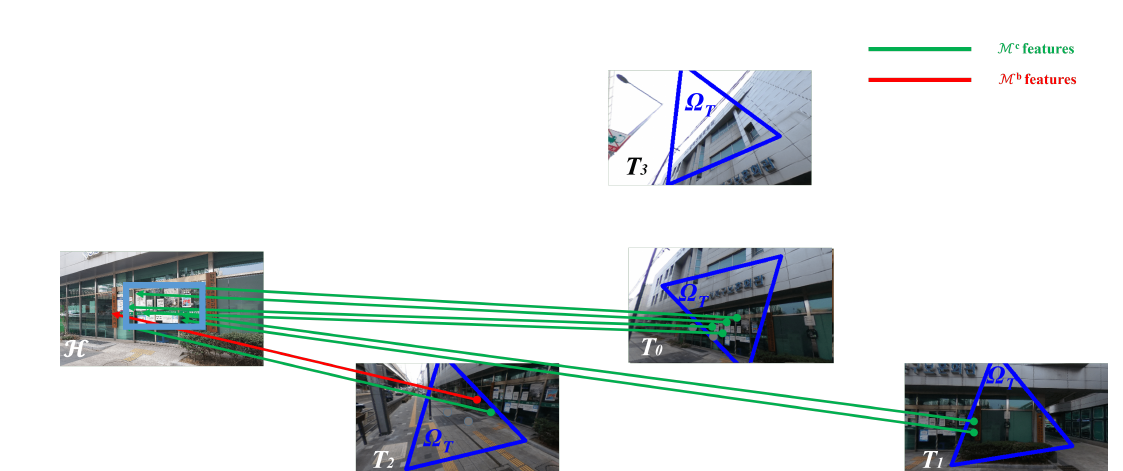
Figure 6. ROI tangent image (ROI-TI) selection. We use the central accumulated matched features (central AMF) M c to pick the ROI-TI. The central AMF has the corresponding features located inside the high angular resolution planar image (HPI) H central region (i.e., the light blue rectangle box). For example, the (TI) T 2 has two features in total, but one is located outside the light blue rectangle. Thus, T 2 only has one central AMF in total. Meanwhile, T 0 has four central AMF in total: the highest among the others. We then select T 0 as the ROI-TI T ROI